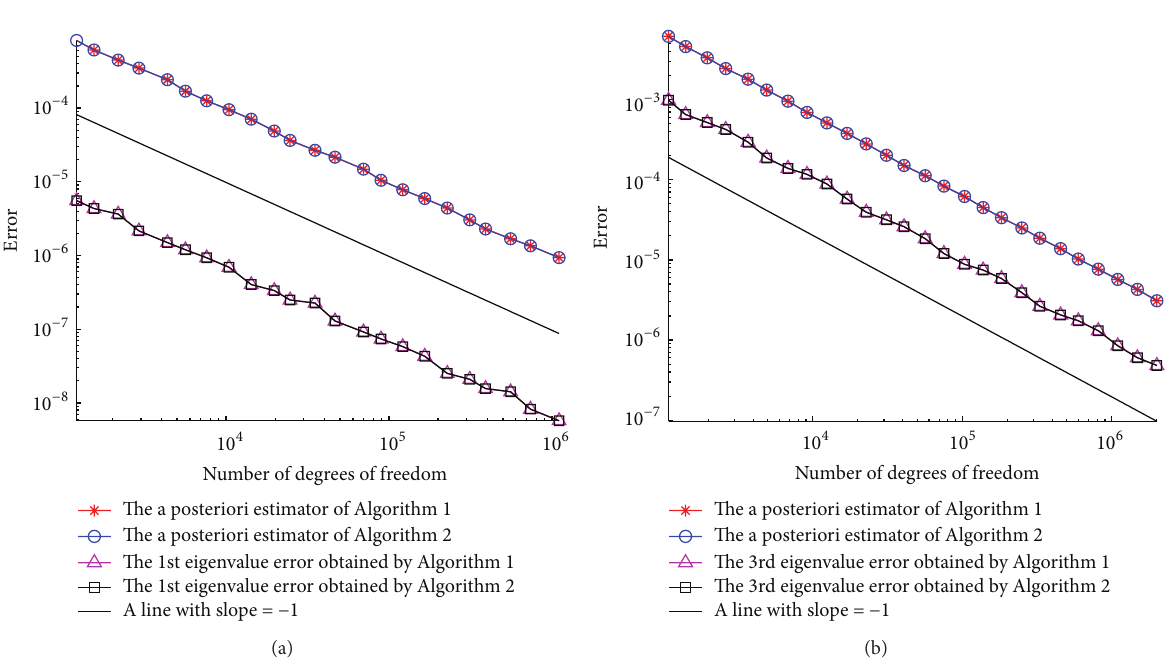
Figure 2: The curves of error and the a posteriori error estimators of two algorithms for the 1st (a) and 3rd (b) eigenvalues on the 𝐿 -shaped domain.